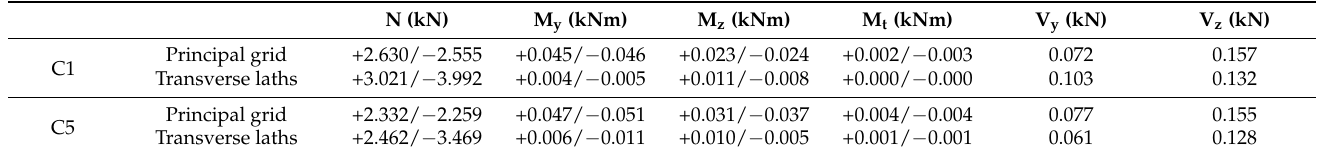
Table 7. Maximum axial force (N), shear force (V) and bending moment (M) in the members from the load test.